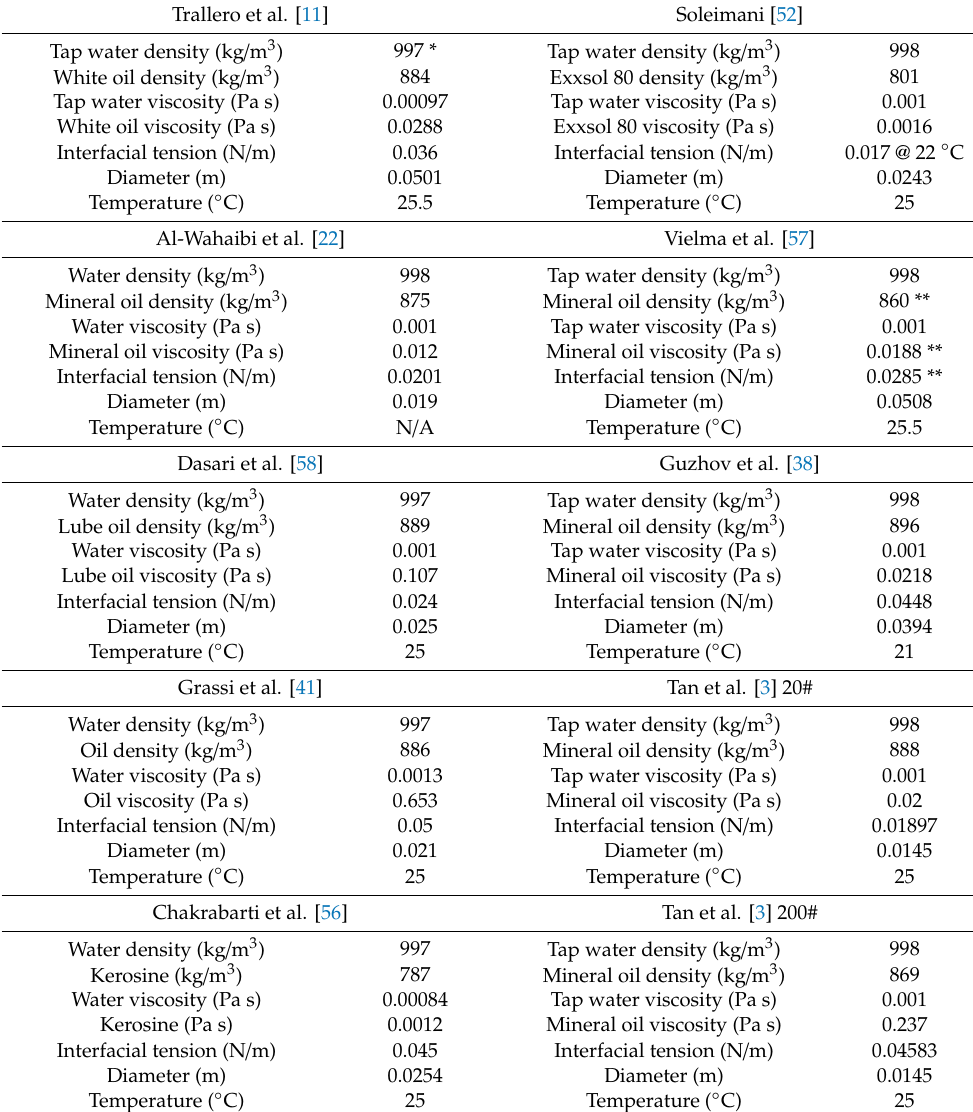
Table 4. Sources of the gathered